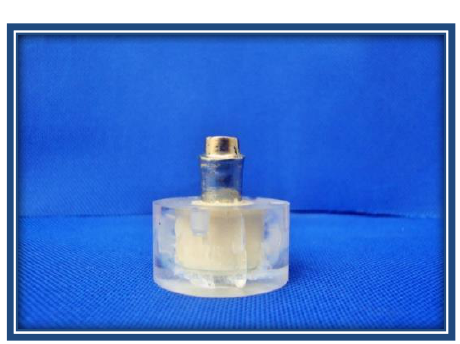
Figure 2: Master Metal die fixed to acrylic base